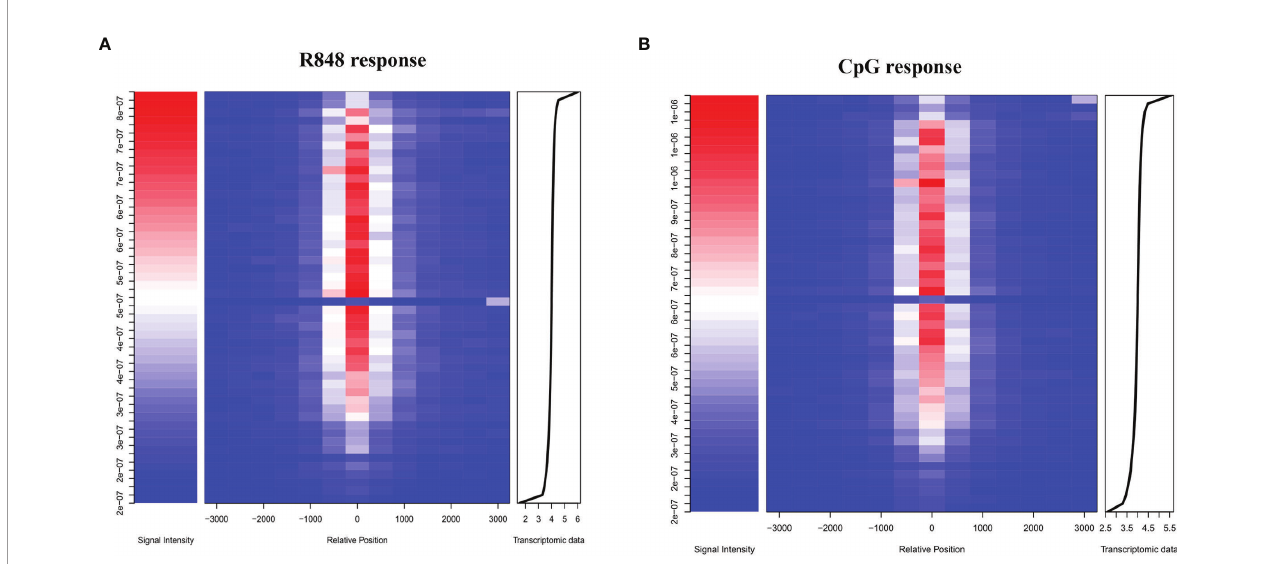
FIGURE 5 | Identi fi cation of immediate target genes of STAT3 after TLRs activation in B cells. Heatmap showing the mean STAT3 ChIP-seq signal near TSS in function of transcriptomic data. The distribution of STAT3-binding sites after TLR7 (A) and TLR9 (B) activation in B cells (middle) and the peak signal densities (left) are shown. Transcriptomic data of B cell after TLRs stimulation were aligned from highest to lowest fold change of gene expression, and the x-axis coordinate of the transcriptomic data was log (FC ∗ 10,000)